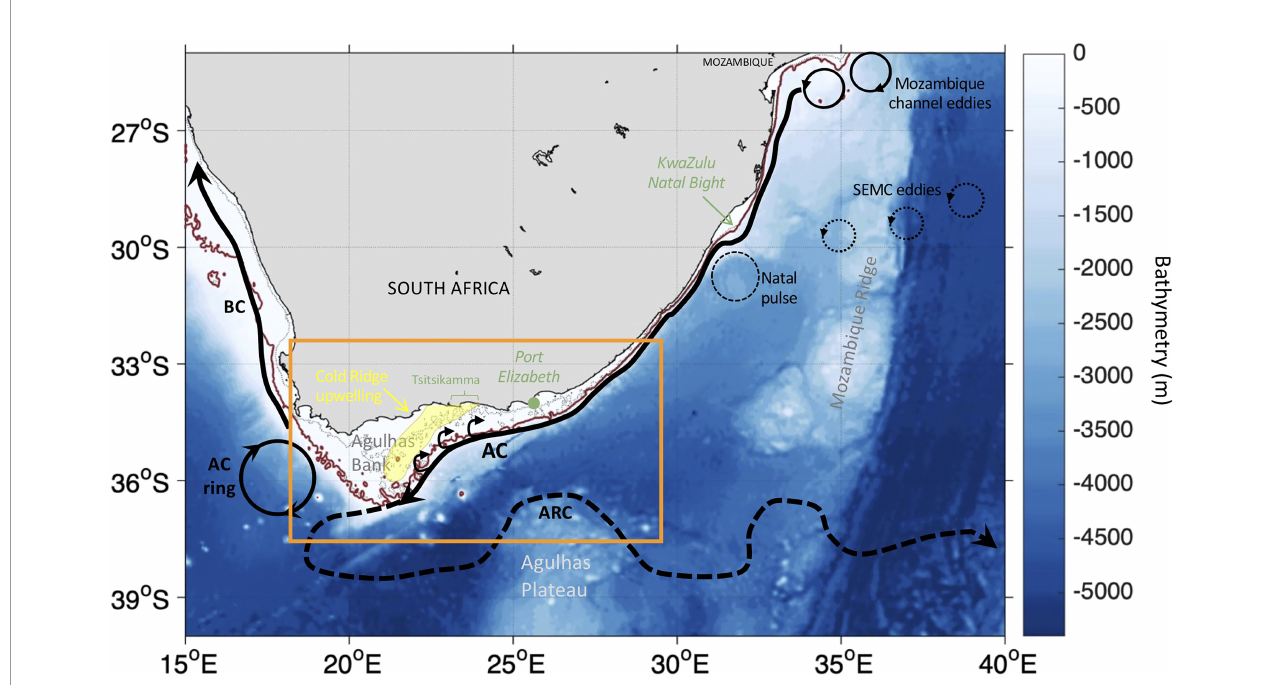
FIGURE 1 | Bathymetry (in m), a schematic of the surface circulation over the Agulhas region based on Lutjeharms, (2006) and Russo et al., (2021) and the area of interest (orange box). The Agulhas Current (AC), the Agulhas Return Current (ARC) and the Benguela Current (BC) are illustrated with the thin black arrows. The thick black arrows along the southern AC at the shelf edge represent shear edge eddies. An AC ring is shown with a thick black circle. Eddies originating from the Mozambique channel and the Southeast Madagascar Current (SEMC) are designated by thin and dotted black circles, respectively. A Natal pulse is indicated with the thin dashed black circle. The approximate locations of the Cold Ridge upwelling is illustrated with a light yellow shaded area. The 100m and 200m isobaths derived from ETOPO2v1 global gridded database are represented by the dotted thin black and solid dark-red lines,